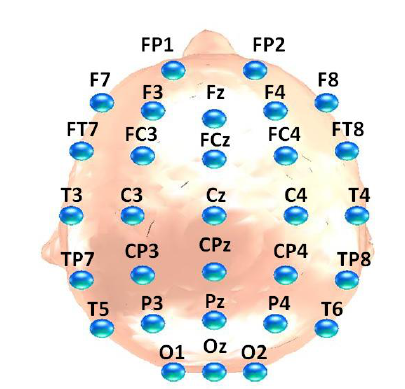
Figure 1. Electrode